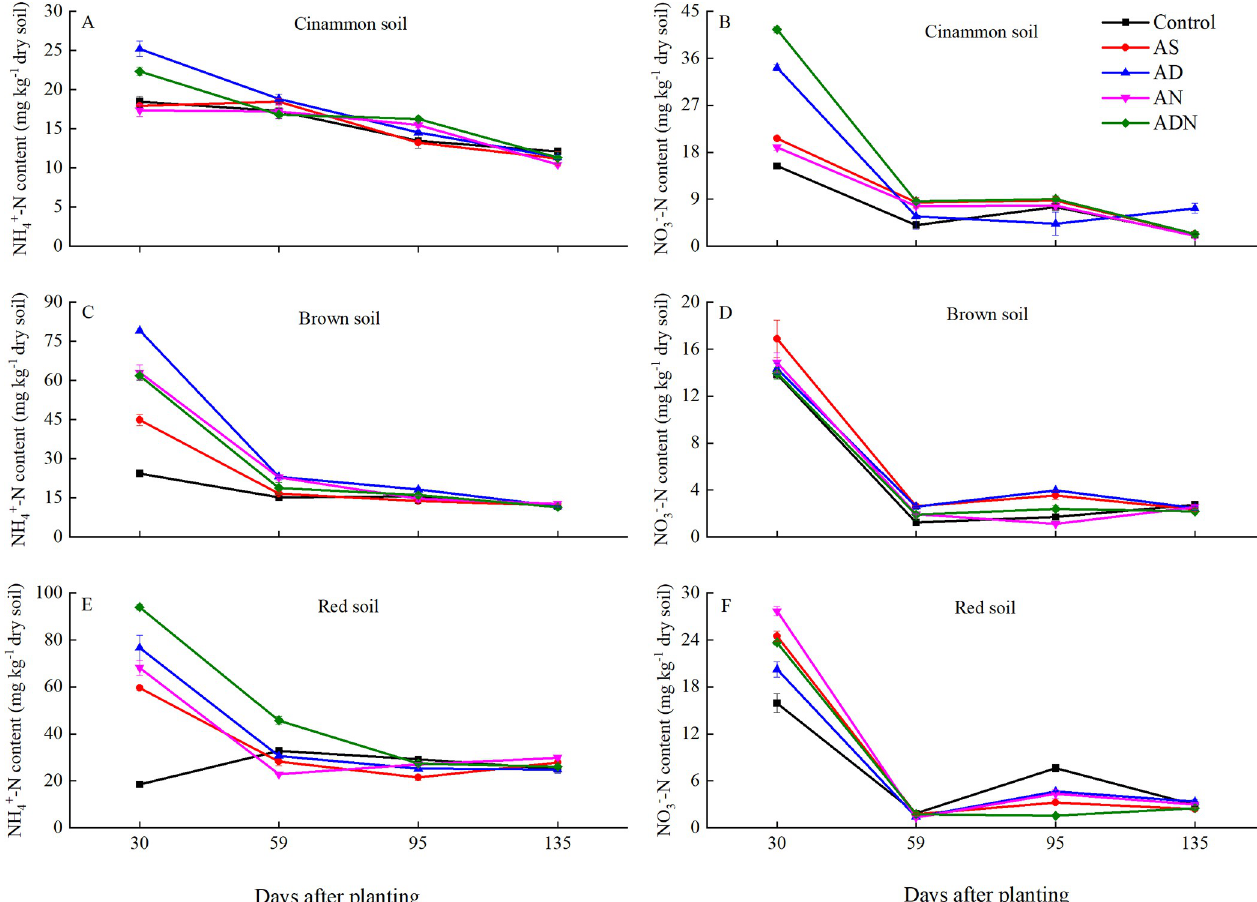
Fig 1. Dynamic changes of NH4+-N and NO3 − -N of different treatments in three soils. Treatment: Control, no fertilizer and nitrification inhibitors; AS, ammonium sulphate; AD, AS+3, 4-dimethylpyrazole phosphate (DMPP); AN, AS+nitrogen protectant (N-GD); ADN, AS+3, 4-dimethylpyrazole phosphate (DMPP)+nitrogen protectant (N-GD). Error bars represented standard deviations ( n = 3).